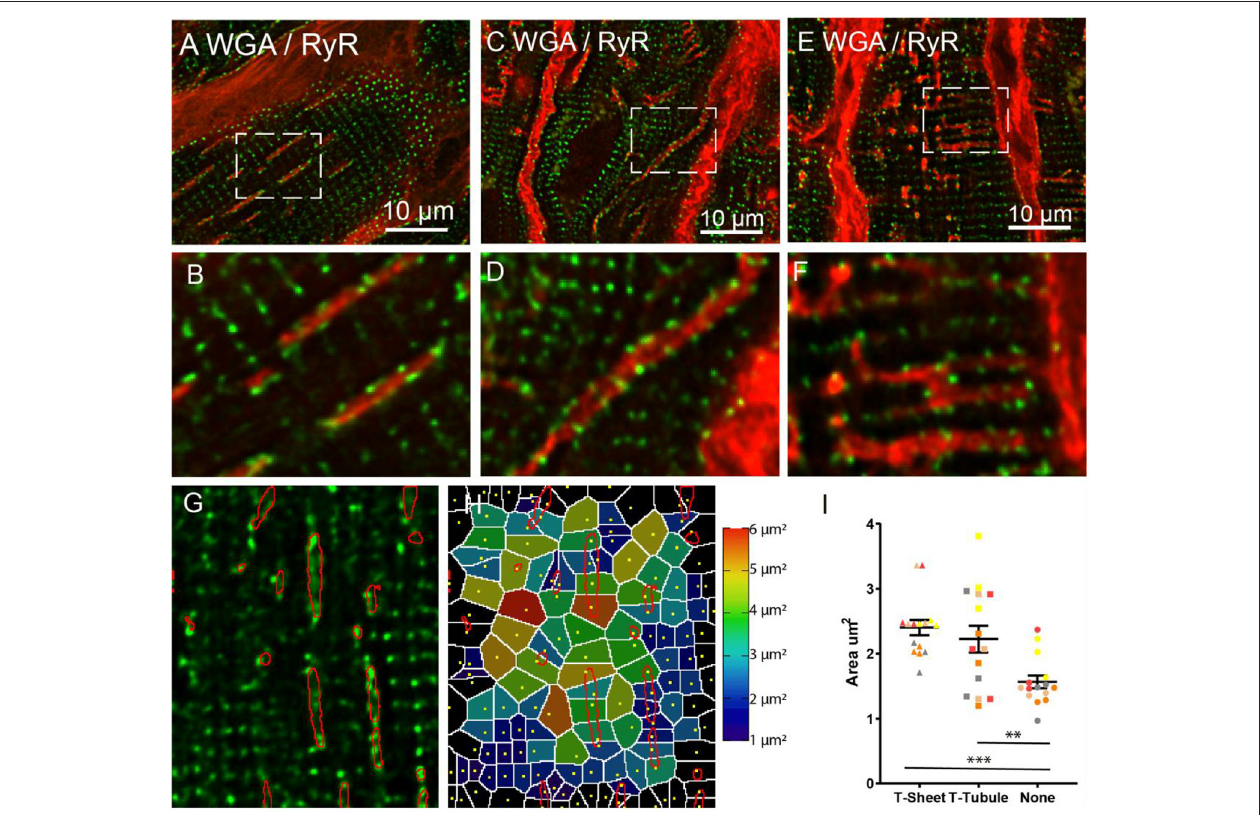
FIGURE 6 | Confocal imaging of WGA labelled t-sheets (red) and ryanodine receptors (green) in the IDCM human heart. (A) 1.5 µ m Z-projection of t-sheets perpendicularly orientated to the image plane. The white arrow points to the plane image of the sarcolemma showing WGA labelling and RyR clusters. (B) Enlargement of the region in “ (A) ”, note area between adjacent t-sheets lacking RyR. (C) T-sheet/enlarged oblique running t-tubule. (D) Enlargement of the region in “ (B) ”, note area between adjacent to t-sheet/t-tubule lacking RyR. (E) Dilated t-tubules. (F) Enlargement of the white box in “ (E) ” showing fused t-tubules. (G) Single plane confocal image of region RyR labelling with t-sheet masks highlighted in red. (H) Voronoi diagram showing the area covered by each RyR cluster, RyR cluster location indicated by yellow dots. (I) The average Voronoi areas from regions with t-sheets, t-tubules, and no WGA labelling (None). For each region n = 5 IDCM hearts, 3 cells were imaged from each heart. ** p < 0.01 and *** p < 0.001. LME model was used to test for effects of the region (t-sheets, t-tubules, and no WGA labelling) and random effects were in the heart. P -values reported are post-hoc comparisons of marginal means using a Sidak test for multiple comparisons. Symbols of the same colour in “ (I) ” are from the same